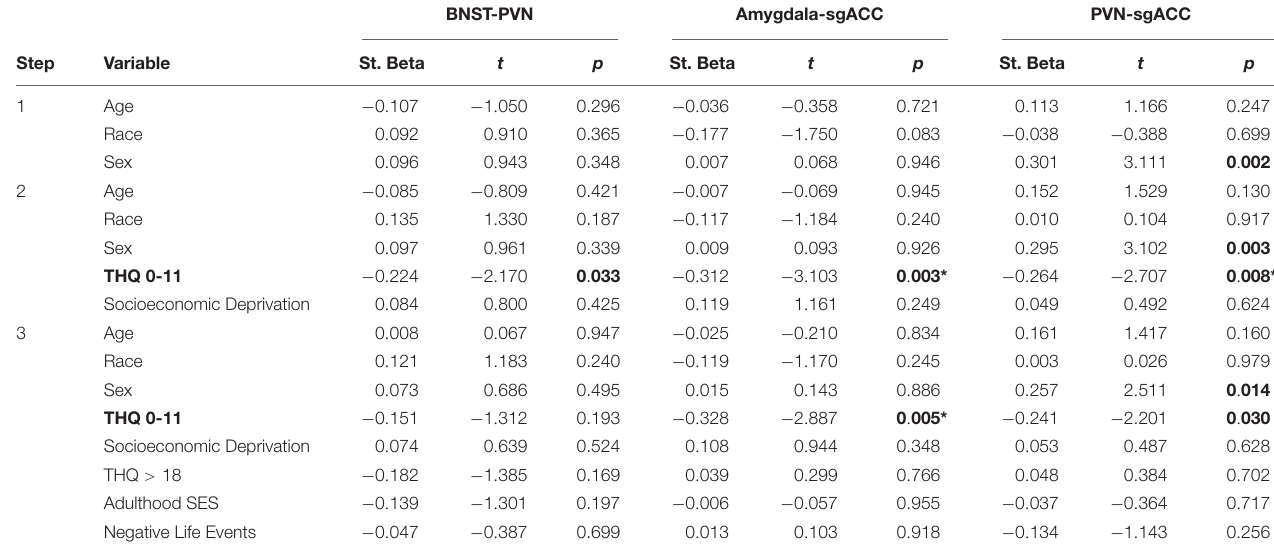
TABLE 2 | Hierarchical linear regression results: childhood threat (early traumatic events, age 0–11) and central visceral network resting-state connectivity.